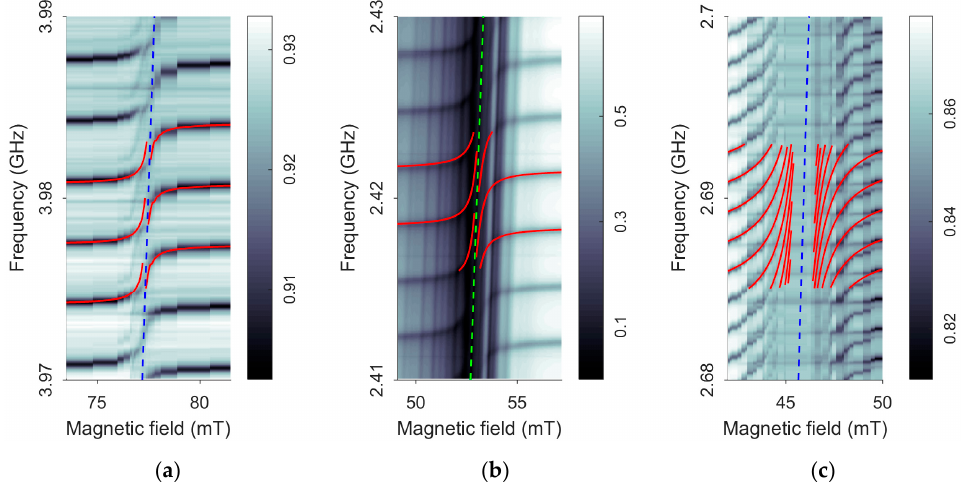
Figure 4. Frequency and magnetic field dependencies of | S 11 ( f , H 0 )| for the devices under study: ( a ) for device 1; ( b ) for device 2; ( c ) for device 3. The red lines are the results of the theoretical calculation with the fitting parameters of Table 1. The dashed lines are the positions of the lines f MER ( H 0 ).